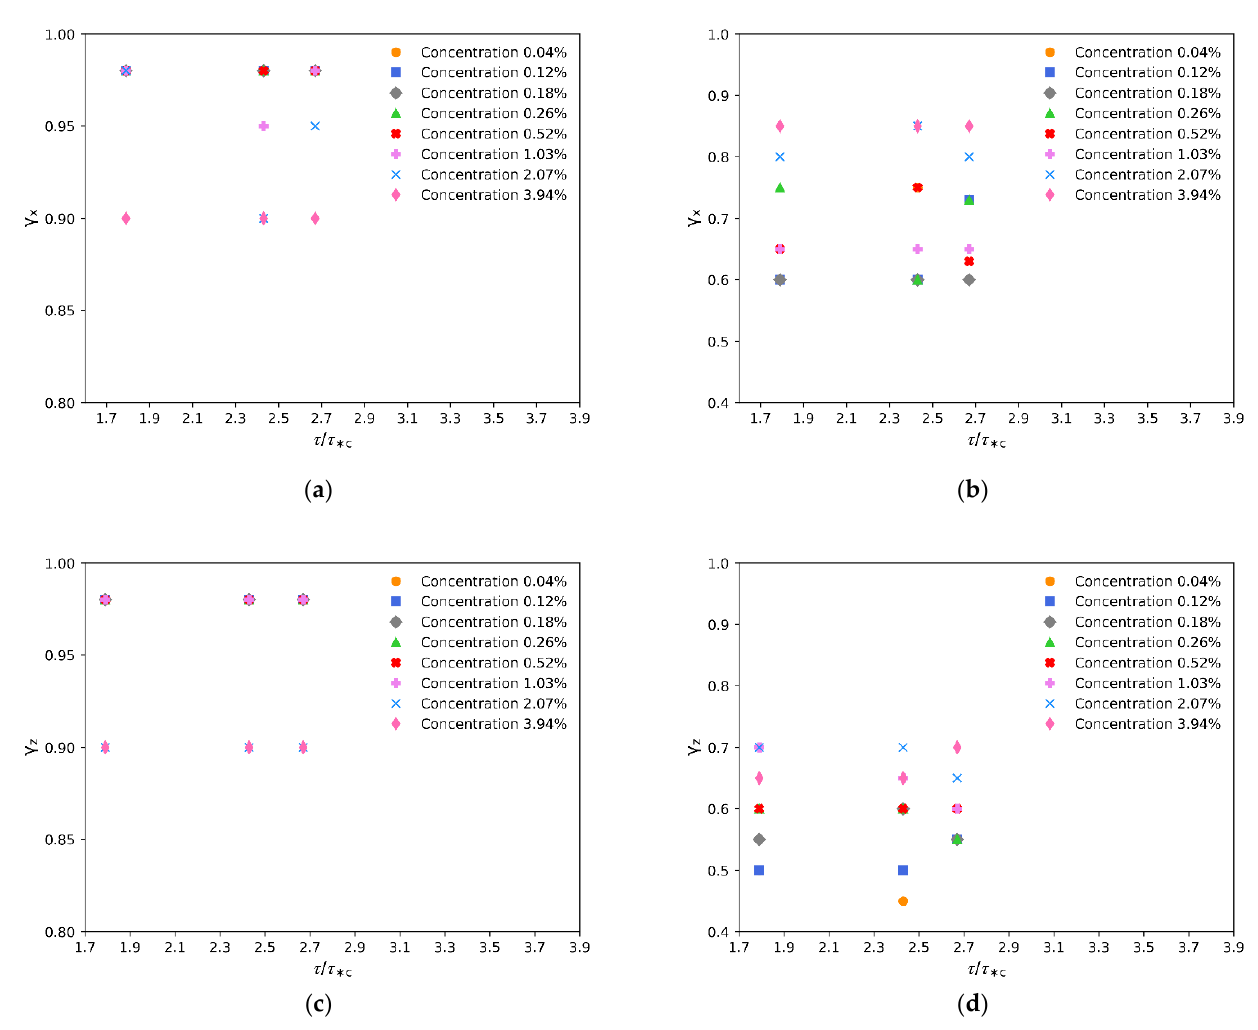
Figure 9. Diffusion results in the X and Z directions for local (ballistic) and intermediate ranges at different particle concentrations. Streamwise diffusion ( γ x ) ( a ) for the ballistic and ( b ) the intermediate range. Spanwise diffusion ( γ z ) ( c ) for the local and ( d ) the intermediate range. Table 4. Summary of values for γ x for particle diffusion in the local range in the X-axis.